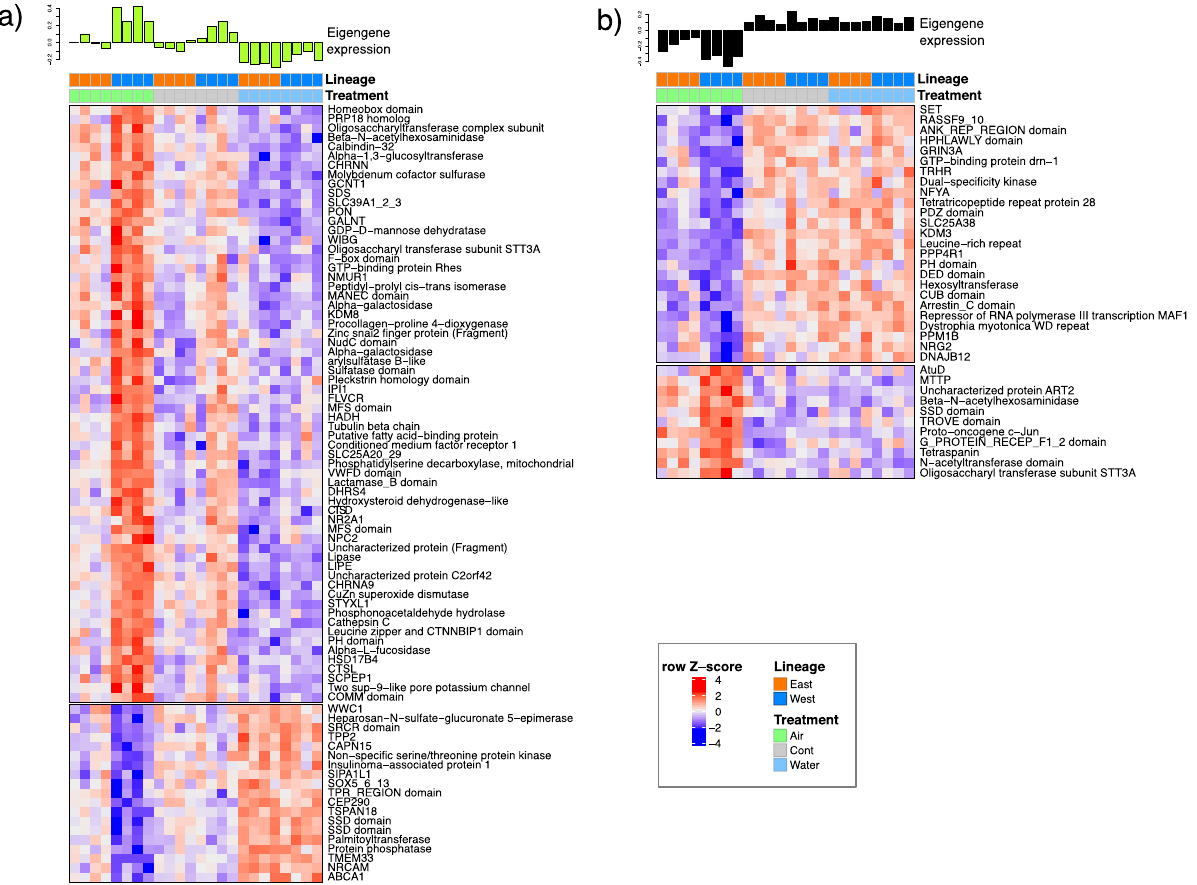
Figure 7. Gene expression heatmaps of annotated transcripts (MM > 0.6, GS > 0.6) in ( a ) green yellow and ( b ) black modules. The per sample eigengene expression is shown above each heatmap showing the correlation with AIR samples from the western lineage. Heatmap colours are scaled by row Z-score; blue = downregulated, red = upregulated genes. Coloured bars at the head of each heatmap indicate the experimental treatment and lineage for each sample as indicated in the legend. Heatmap was produced using R/Bioconductor package ComplexHeatMaps 42 (http:// bioco nduct or. org/ packa ges/ relea se/ bioc/ html/ Compl exHea tmap.